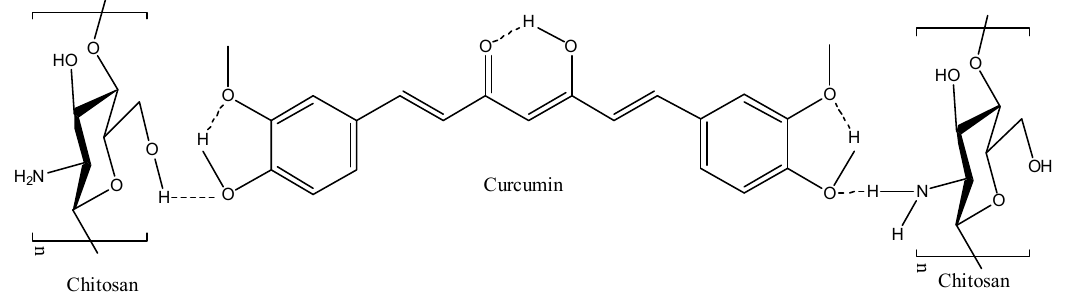
Figure 6. Probable interactions between curcumin and chitosan molecules.